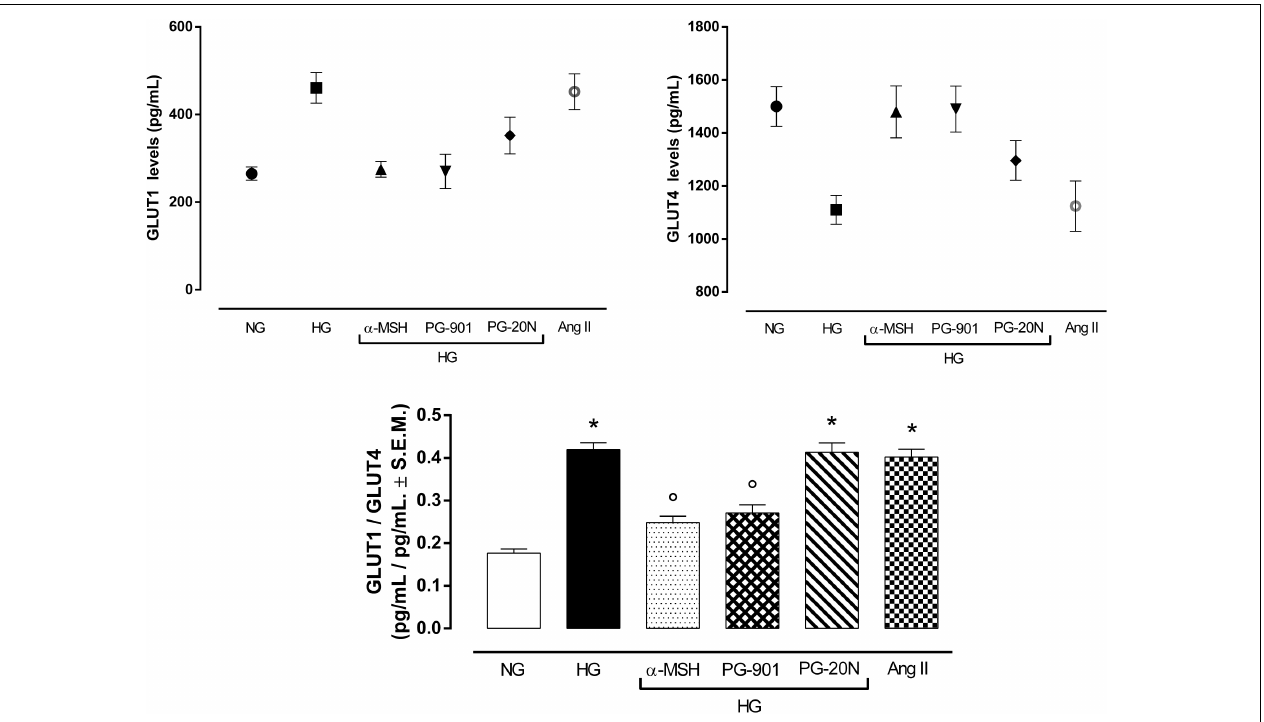
FIGURE 7 | Plasma membrane GLUT1 and GLUT4 levels. In line with previous evidences, H9c2 cells exposed to high glucose (33 mM D -glucose) exhibited lower GLUT4 levels and increased GLUT1 levels in plasma membrane, resulting in a higher GLUT1/GLUT4 levels compared to cells exposed to normal glucose (5.5 mM D -glucose). a-MSH (90 pM) and PG-901 (10 − 10 M) significantly restored GLUT1/GLUT4 ratio, by increasing GLUT4 and consequently decreasing GLUT1 plasma membrane levels. PG-20N MC5R antagonist (130 nM) did not lead to any modification of the high GLUT1/GLUT4 ratio induced by high glucose. Values are expressed as mean ± S.E.M. of n = 9 values, obtained from the triplicates of three independent experiments. NG, normal glucose; Ang II, angiotensin II; HG, high glucose; ∗ P < 0,01 vs. NG; ◦ P < 0,01 vs. HG. TABLE 1 | In vivo cardiac parameters evaluated by echocardiography.